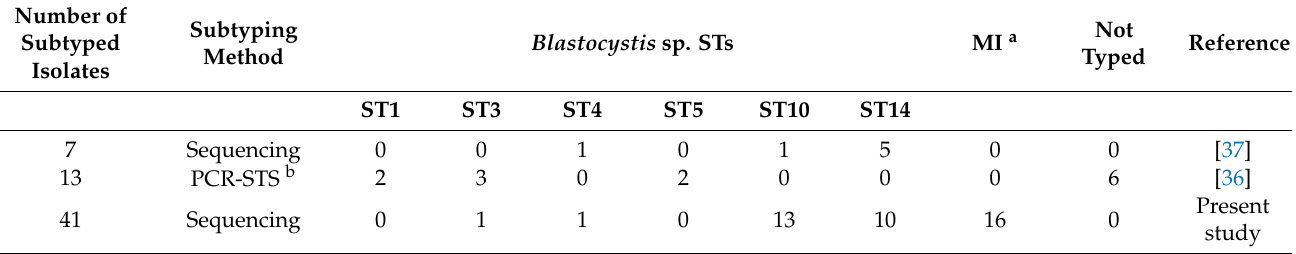
Table 2. ST distribution of Blastocystis sp. in domestic cattle in